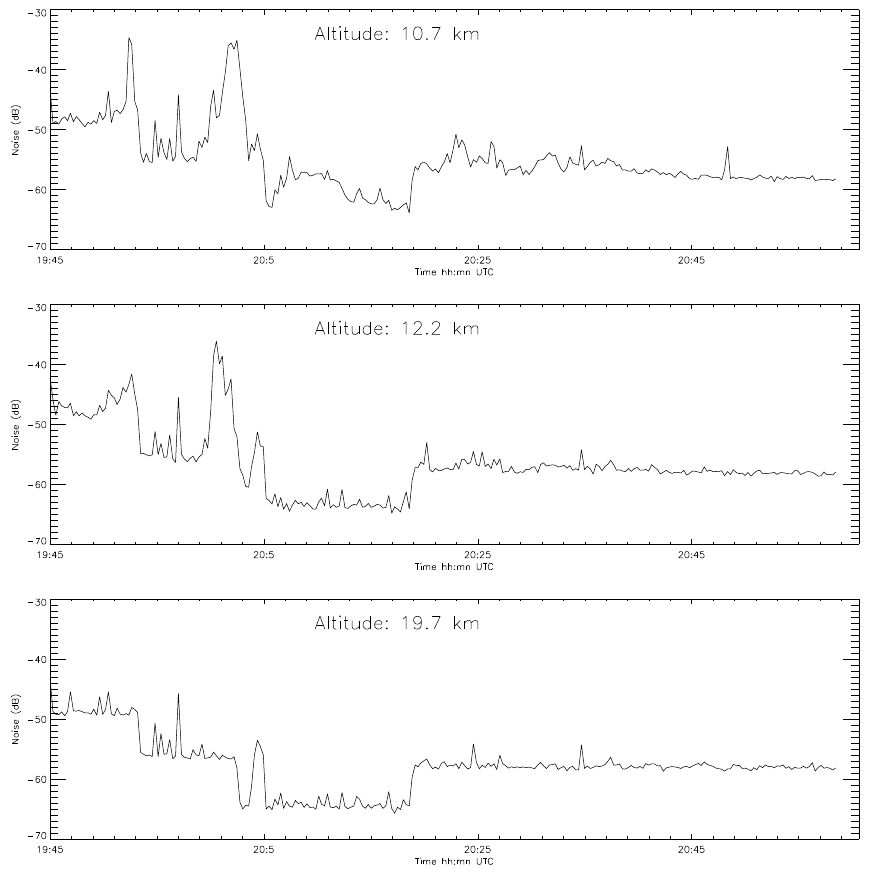
Fig. 6. Variation of the UHF noise power spectral density as a function of time at different altitudes, from top to bottom, 10.7km, 12.2km and